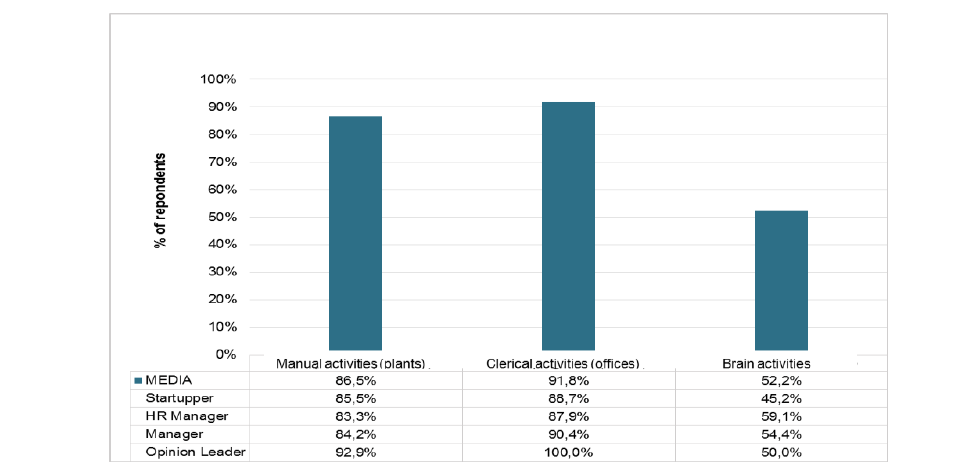
Figure 2. Will Computers and Robots Replace Human